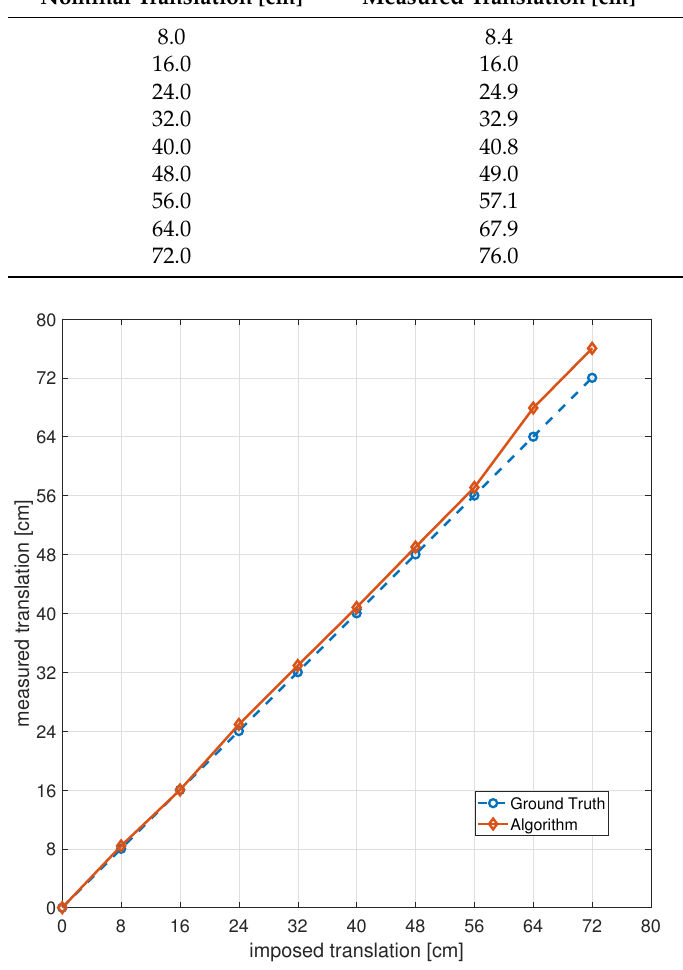
Figure 11. Comparison of the imposed translations with the measured ones.